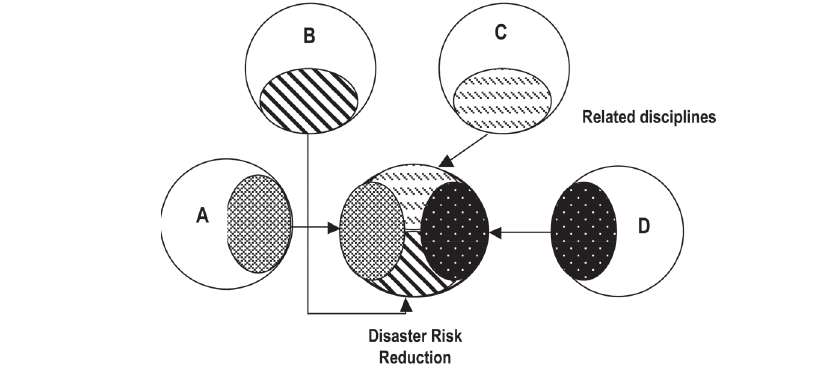
Figure 2: Enrichment of Disaster Risk Reduction as a discipline